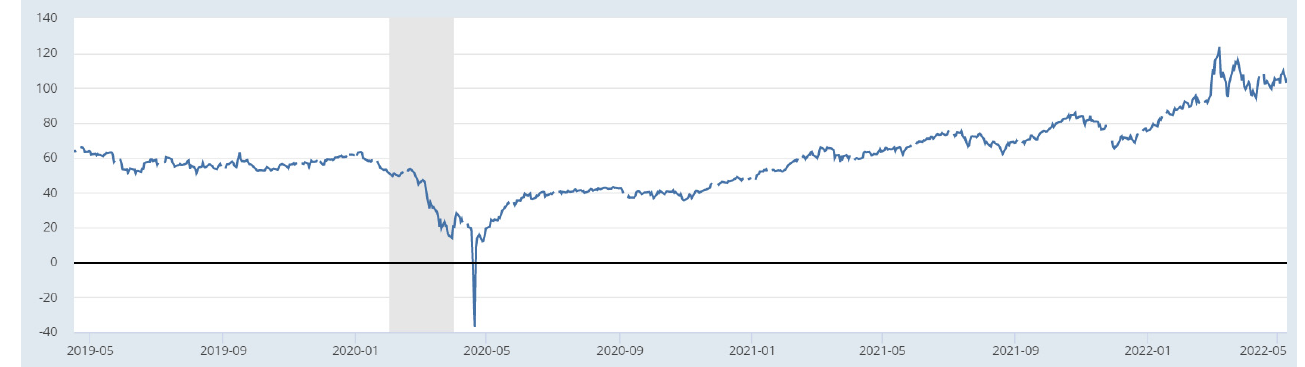
Figure 2. Crude Oil prices: West Texas Intermediate. Source: U.S. Energy Information Administration, Crude Oil Prices: West Texas Intermediate (WTI)—Cushing, Oklahoma [DCOILWTICO].